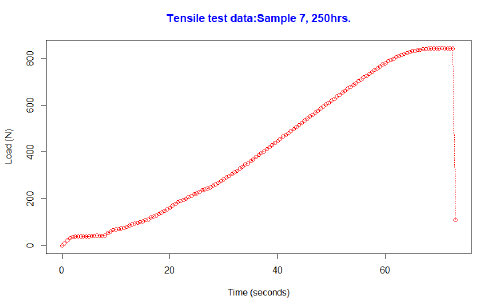
Figure 1. Tensile